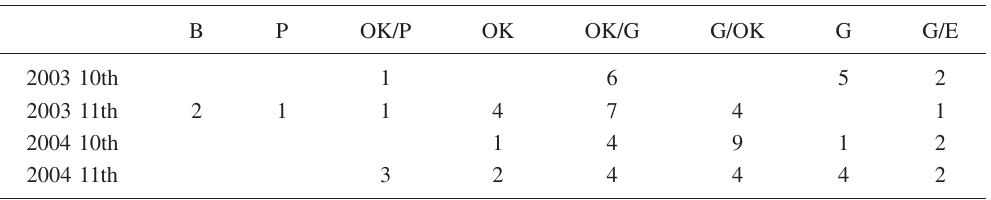
TABLE IX. Numbers of physics and physical science items receiving each overall rating (cid:1) or combination thereof (cid:2) for each grade level in each year.